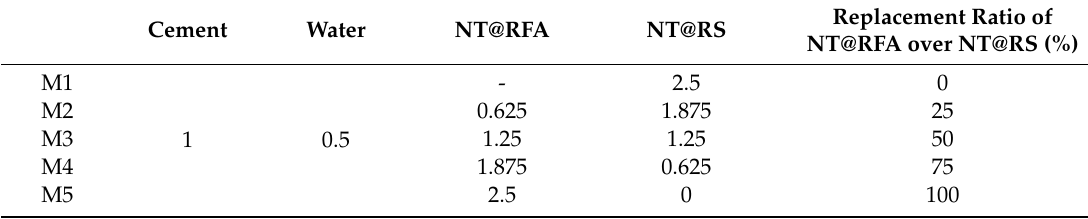
Table 3. Mix proportion of photocatalytic mortar.